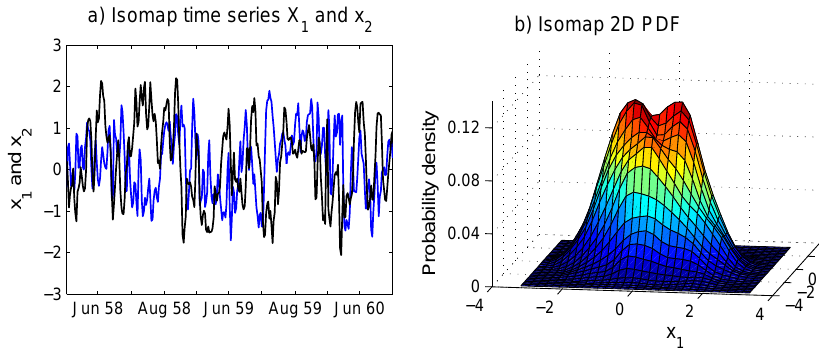
Fig. 6. The leading two Isomap time series from the SLP anomalies (a) and the associated kernel PDF estimate (b) .